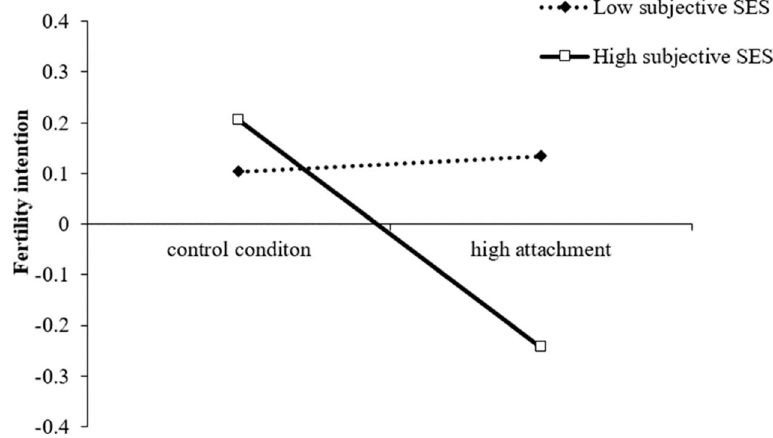
Figure 3. Interaction between subjective SES and pet attachment on fertility intention.